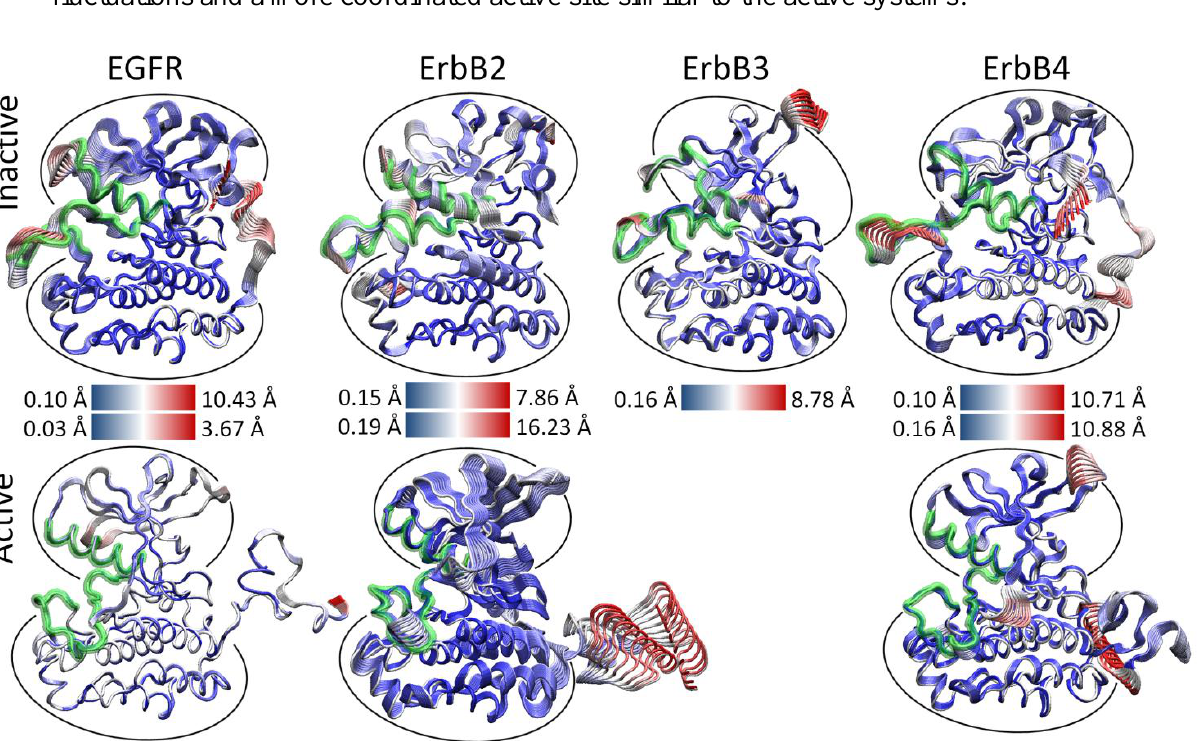
monomer kinase systems. The simulations are fully atomistic, solvated and charge neutral; water and ions are not shown here. The structures are color-coded according to the RMSD, where red regions indicate large-amplitude fluctuations and blue regions indicate small-amplitude fluctuations. The active ErbB systems show a highly coordinated active site with no majority of the motions focused only on the freely movable N - and C -terminal tails. The inactive canonical ErbB (EGFR, ErbB2, ErbB4) systems have large local motions concentrated on the A-loop and αC-helix in addition to the tail motions. Despite the ErbB3 kinase in an inactive-like conformation, the ErbB3 kinase has low-amplitude fluctuations and a more coordinated active site similar to the active